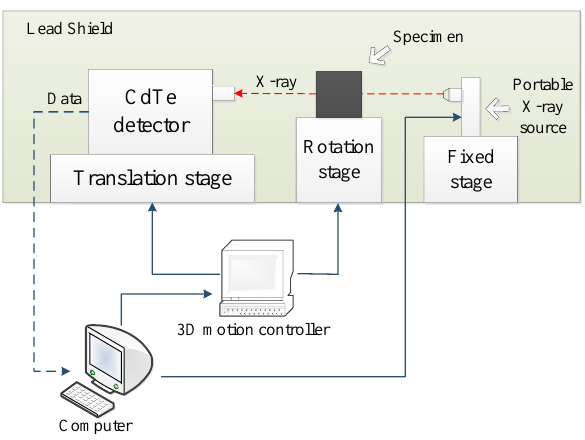
Figure 1. Hardware structure diagram of X-ray Absorption Spectrum acquisition system.